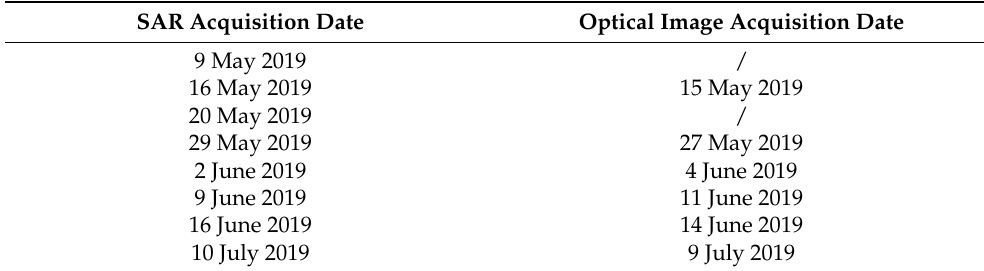
Figure 2. Ground truth photos of winter wheat. ( a ) 9 May. ( b ) 27 May. ( c ) 9 June. ( d ) 10 July 2019. Table 1. Acquisition date of SAR and optical